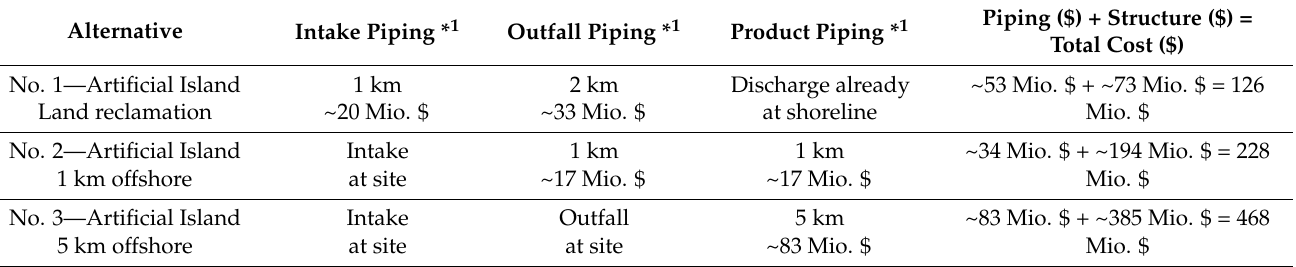
Table 7. Direct investment costs for all offshore alternatives including piping and the marine structures.